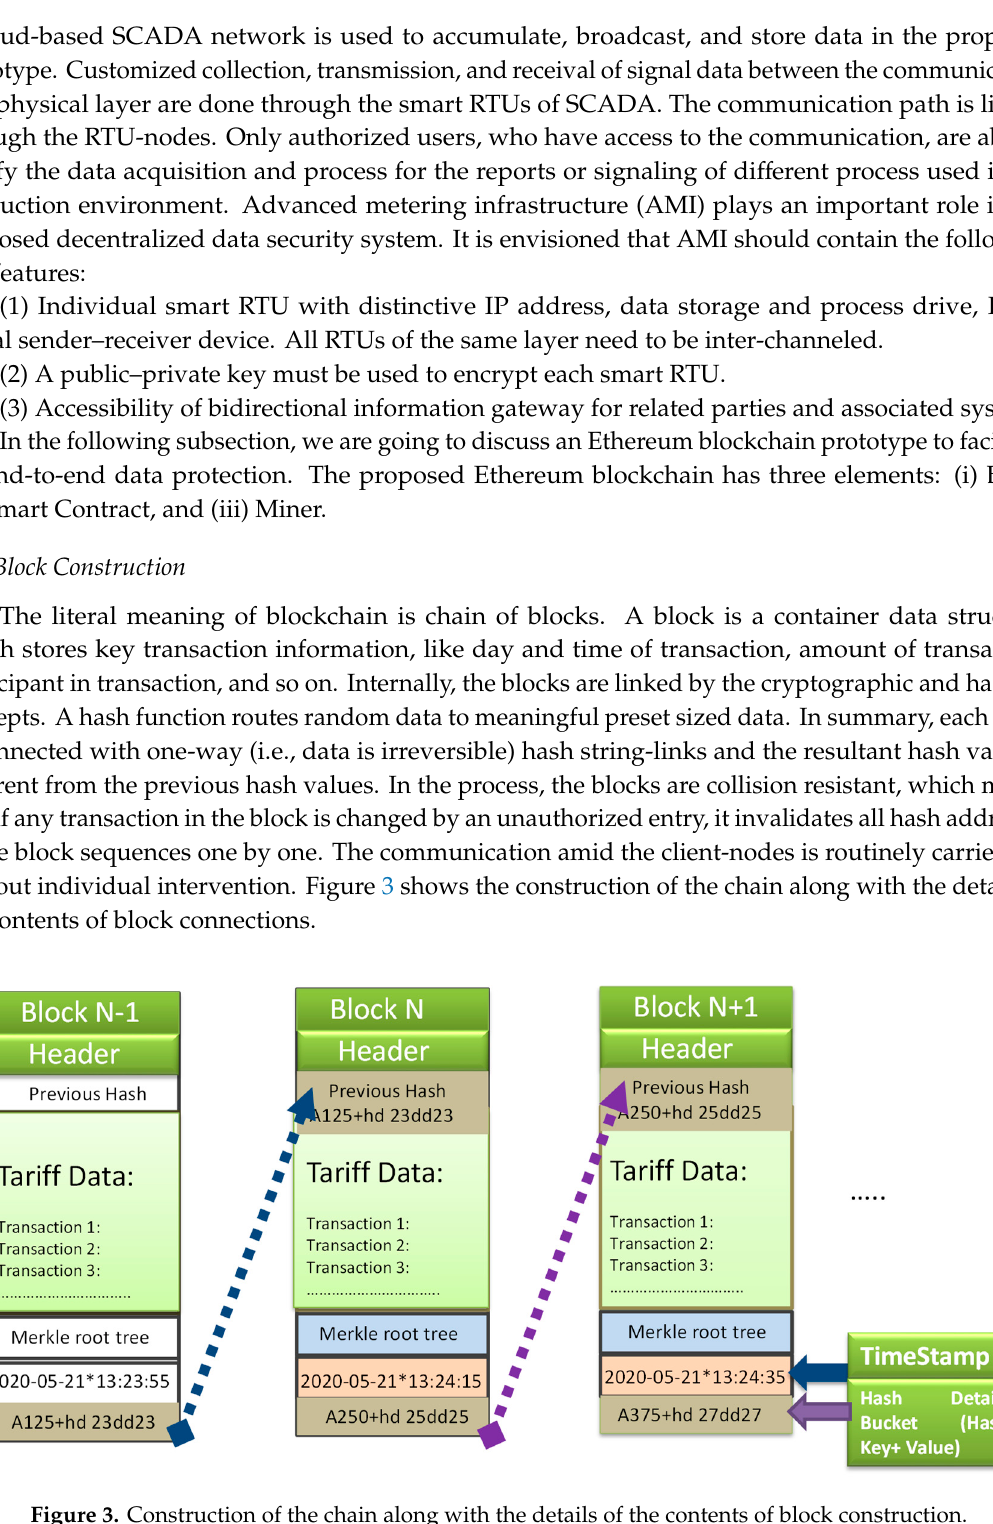
Figure 3. Construction of the chain along with the details of the contents of block construction .